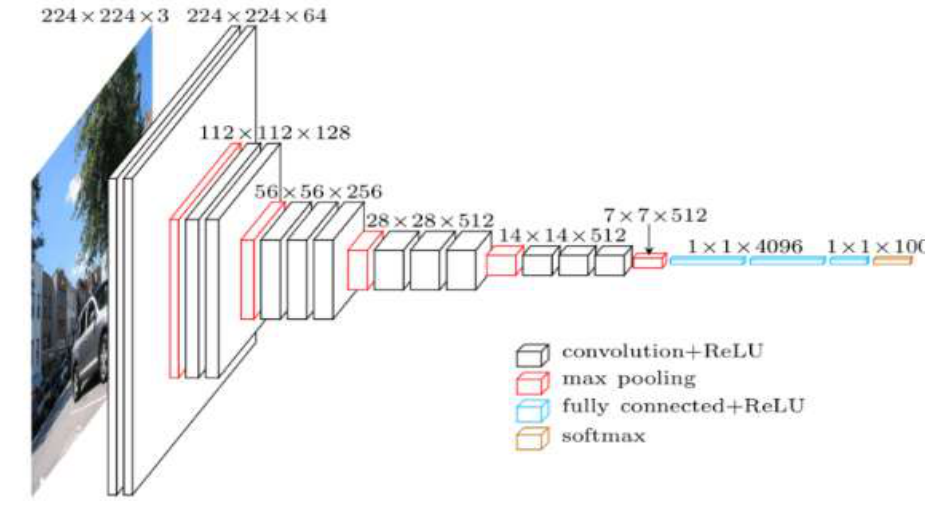
Figure 1. VGG-16 Architecture [27,28].